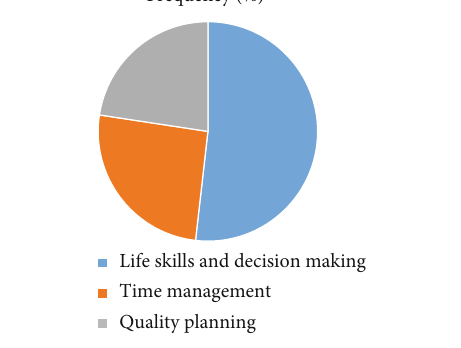
Figure 1: Graph of demographics against %